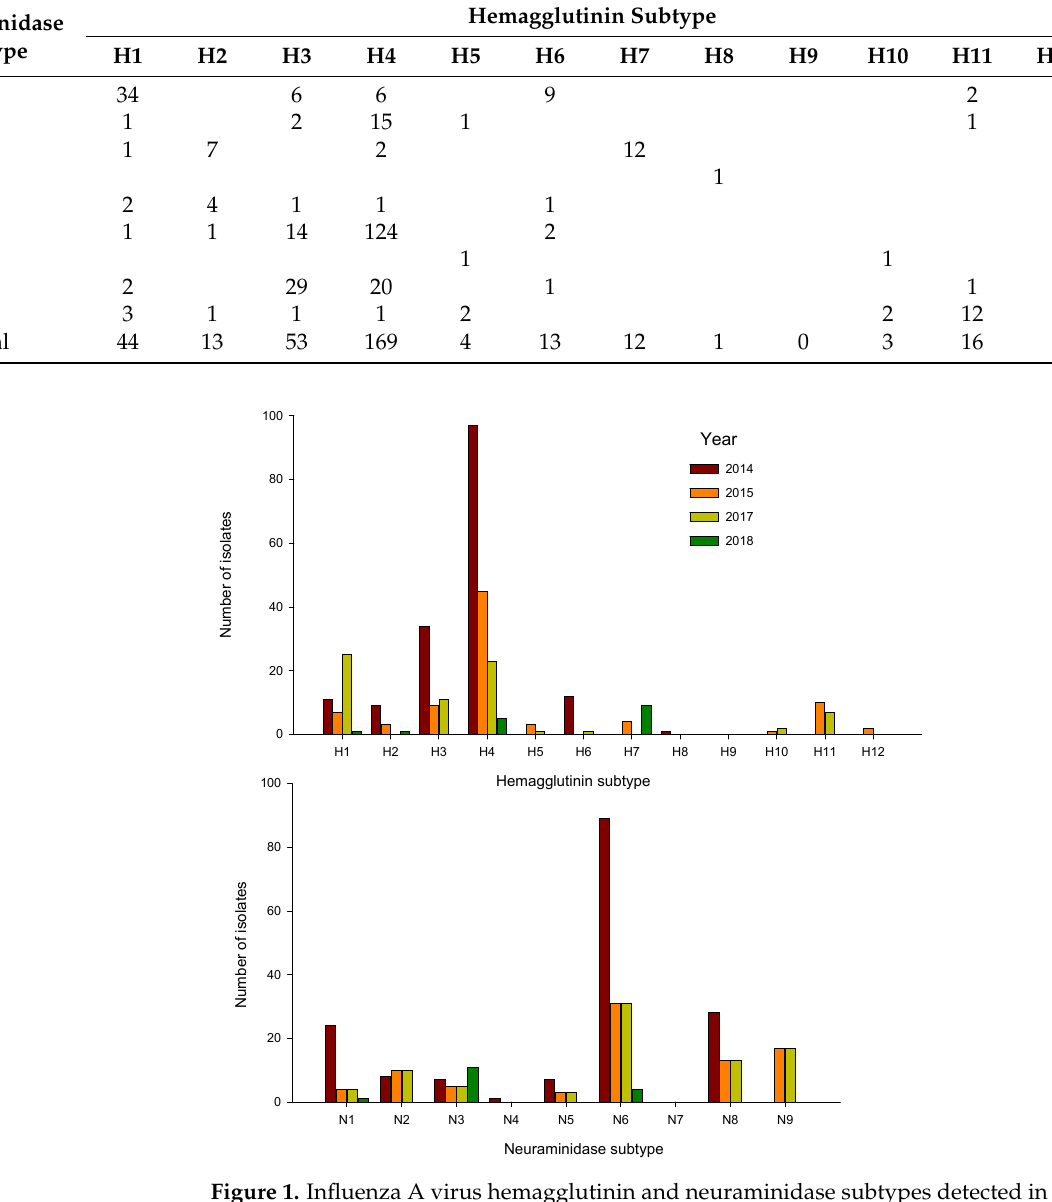
Figure 1. Influenza A virus hemagglutinin and neuraminidase subtypes detected in wild mallards sampled in Northwest Minnesota, USA during 2014, 2015, 2017, and 2018. NP antibody prevalence: A high antibody prevalence was detected in both HY and AHY birds (Table 2). Depending on the year, NP antibody prevalence ranged from 50.7% to 76.1% in HY and from 86.0% to 92.7% in AHY mallards. Overall, antibody prevalence estimates were significantly higher ( p ≤ 0.001) for AHY (90.1%) than HY (59.3%) mallards. For individual years, antibody prevalence was significantly higher in AHY than HY birds in 2015 ( p ≤ 0.001) and 2018 ( p = 0.001); although a significant difference could not be de- tected, antibody prevalence estimates for AHY ducks did exceed those for HY birds dur- ing 2014 and 2017. HA and NA antibody prevalence: Neutralizing antibodies were detected against H3, H4, and H5 in all years (Table 3). For the total sample, significant differences in antibody prevalence between HY and AHY birds were detected for H3 ( p = 0.02) and H5 ( p ≤ 0.001). For H4, a significant difference in antibody prevalence observed in HY (30%) and AHY (36%) birds was not detected. Antibodies to N1, N2, N6, and N8 were detected in birds in all years (Table 3). For the total sample, significant differences in antibody prevalence be- tween HY and AHY birds were detected for N1 ( p ≤ 0.001), N2 ( p ≤ 0.001), and N8 ( p ≤ 0.001). For N6, significant differences between antibody prevalence estimates for HY (78%) and AHY (83%) were not detected. A high proportion of NP seropositive ducks tested positive for antibodies to multiple HA and NA subtypes, and this was more com- mon in the AHY age class (Figure 2). For HY and AHY birds, 22% and 50% ( p = 0.004) tested seropositive for more than one of the three HA subtypes included in this study, respectively. For HY and AHY birds, 51% and 85% ( p = 0.002) tested seropositive for more than one NA subtypes, respectively. Of the H3 seropositive mallards, 94% and 91% percent tested positive to N6 and N8, respectively. For H4 seropositive birds 100% and 63% percent tested seropositive to N6 and N8, respectively.